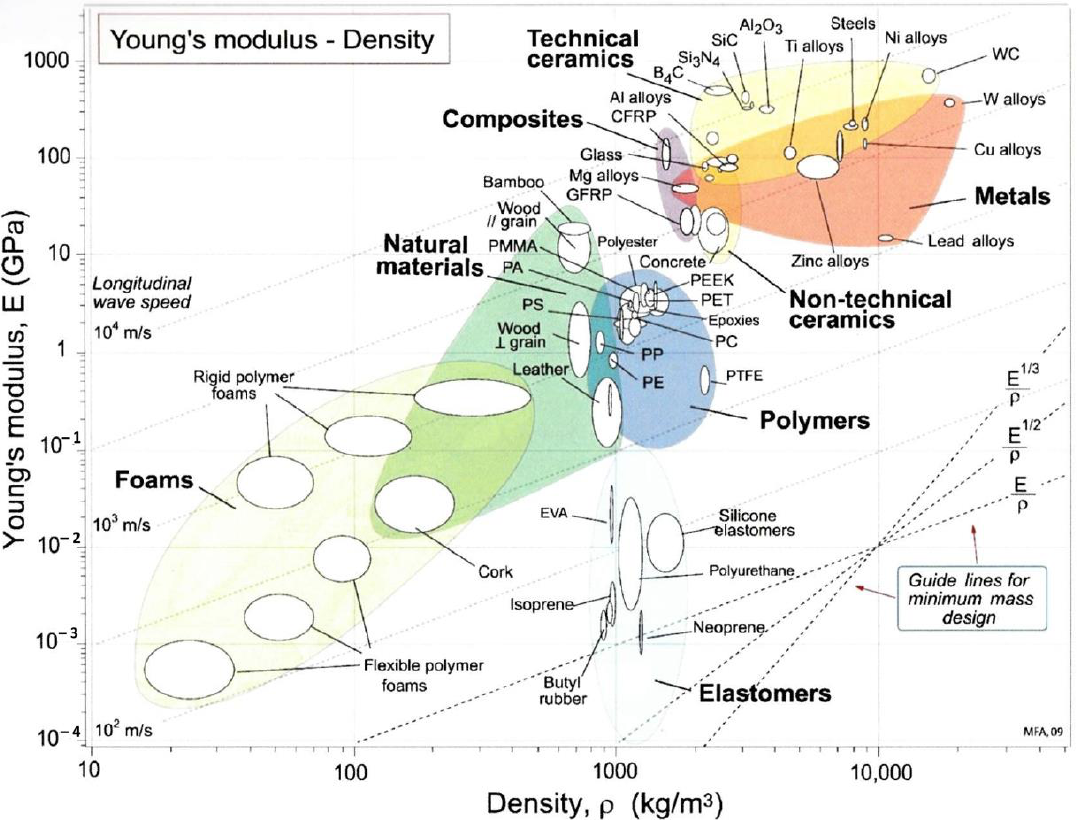
Figure 3. Example of the Ashby map, log (Young’s modulus) vs. log(Density) [28].